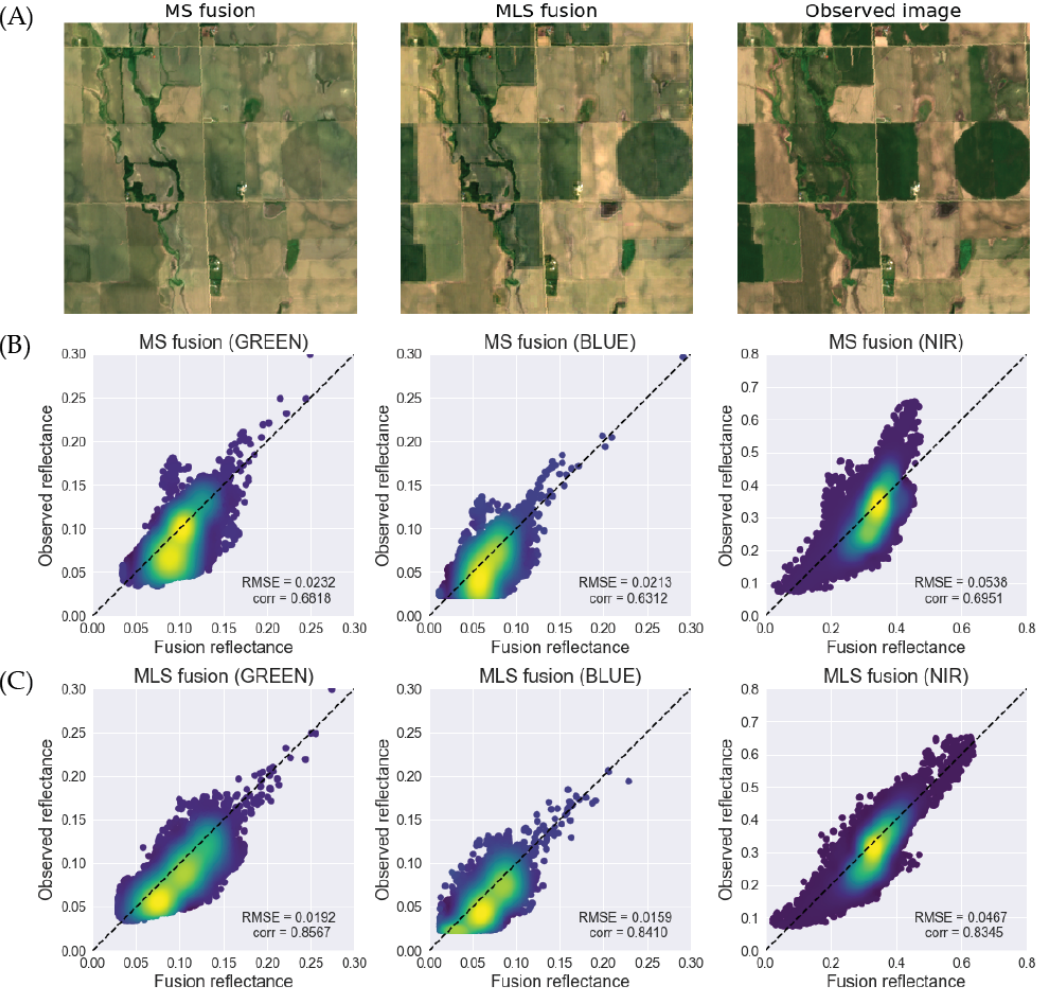
Figure 7. Advantages of fusing multiple satellite datasets. STAIR 2.0 under MS and MLS settings was applied to produce a fusion image for an area in Saunders, NE, on June 29, 2017. The fusion image produced by MS fusion and MLS fusion are compared to the observed image, respectively. ( A ) RGB visualizations of MS fusion image, MLS fusion image, and the observed image; ( B ) scatter plots of observed and fusion reflectance generated by MS fusion for green, blue, and NIR bands; and ( C ) scatter plots of observed and fusion reflectance generated by MLS fusion for green, blue, and NIR bands.